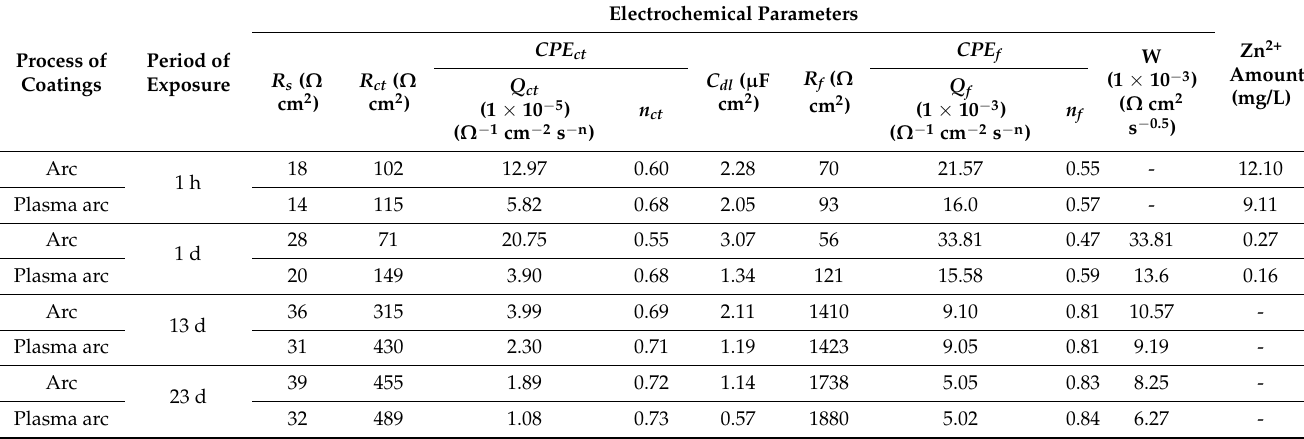
Table 4. Electrochemical parameters of the Zn coating obtained after the fitting of EIS plots in suitable EECs for different exposure periods in an artificial seawater